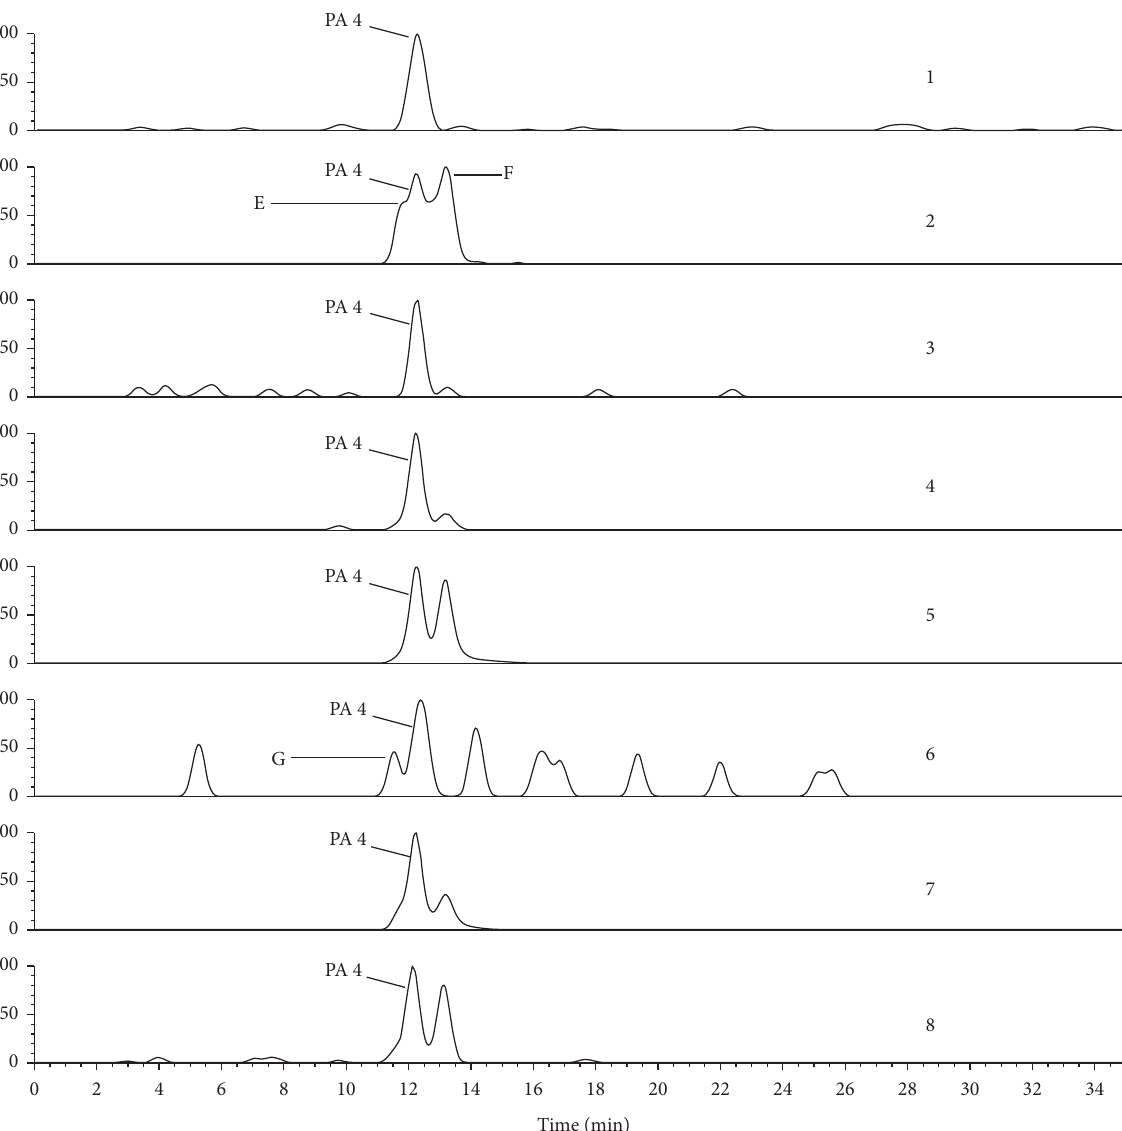
Figure 1: Chromatogram of total MS/MS fragment ions of 336 of eight Senecio plants. According to identification, PA4 is senecionine and E, F, and G are three other PAs which are the isomers of senecionine. Plant materials are as follows:1 , Senecio scandens; 2, Senecio argunensis ; 3, Senecio cannabifolius var . integrifolius ; 4, Senecio cannabifoliu s; 5, Senecio vulgaris ; 6, Tephroseris phaeantha ; 6, Senecio laetus ; and 8, Senecio